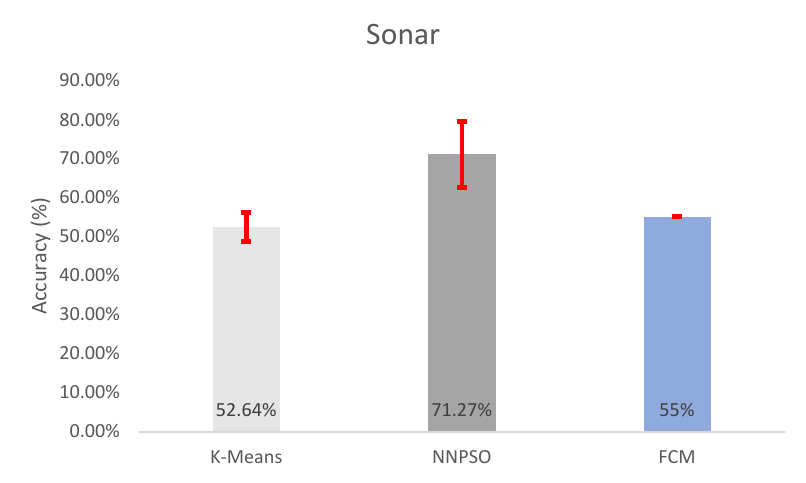
Figure 23. Accuracy of the algorithms on the Mammographic Mass data set.